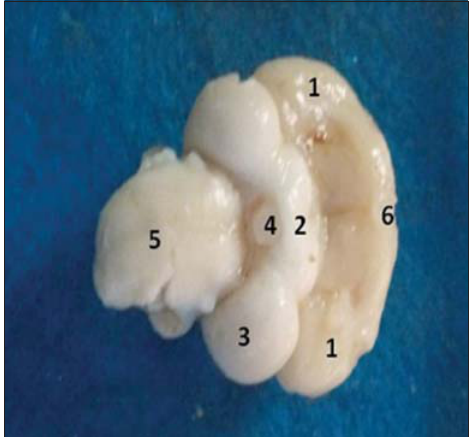
Figure-2: Ventral view of brain showing different gross anatomical parts. (1) Cerebral hemisphere, (2) Optic chiasma, (3) Optic lobe, (4) Hypothalamus, (5) Medulla oblongata, (6) Olfactory